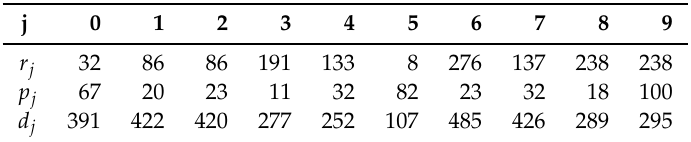
Figure 1. Graphics of the initial Earliest Due-date (ED)-schedule σ ; kernel jobs are in red, emerging job are in green and the rest of the jobs are in blue. Table 3. Data of a modified